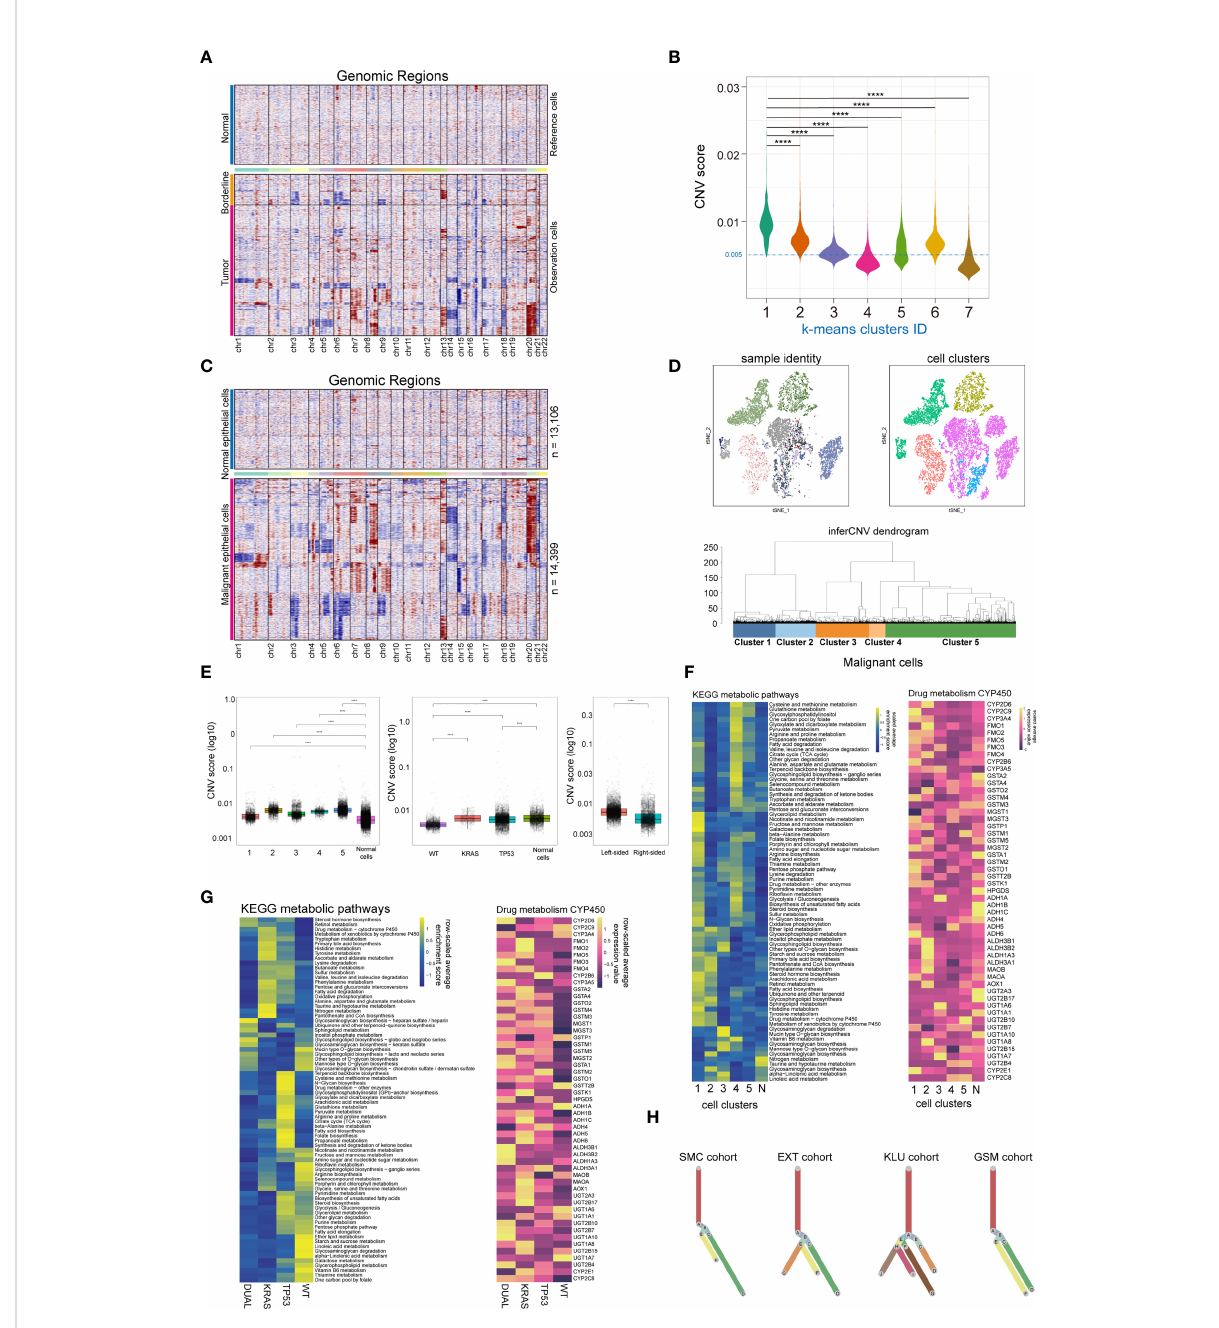
FIGURE 2 Single cell copy-number variation and clonal evolution of malignant epithelial cells. (A) Heatmap depicted copy-number variation (CNV) hierarchical clustering of epithelial cells in colorectal tumor and tumor adjacent tissues, with normal mucosa epithelial cells as a reference. (B) Violin plot showed the CNV score across 7 epithelial cell subclusters across normal mucosa, tumor adjacent and tumor tissue, with cells from cluster 4 and 7 classi fi ed as normal epithelial cells. (C) Heatmap depicted CNV hierarchical clustering of putative malignant epithelial cells (n = 14399). (D) The subclusters and distribution patterns of malignant epithelial cells were depicted by the t-SNE (upper) and cluster tree (bottom) plots. (E) The boxplots depict the CNV scores of malignant epithelial cells based on subcultures (left), KRAS/TP53 mutation status (middle), and tumor sideness (right). (F) A heatmap of signi fi cantly altered metabolic pathways (p 0.001) in malignant epithelial cells across multiple subclusters (left), as well as the expression of representative genes in Drug metabolism CYP450 pathways (right). (G) A heatmap of signi fi cantly altered metabolic pathways (p 0.001) of malignant epithelial cells, as well as the expression of representative genes in Drug metabolism CYP450 pathways (right) based on KRAS/TP53 mutant status. (H) Clonality trees depicted the heterogenicity of evolution trajectories across the four cohort. The branches are determined by the proportion of cells in each subclone that contain the respective CNV events. ****p <